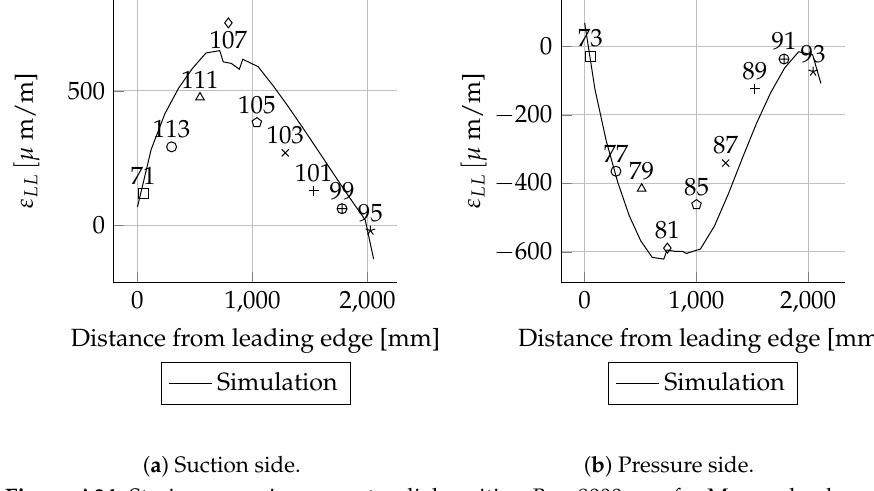
Figure A34. Strain comparison ε TT at radial position R = 8000 mm for Mymax load case.